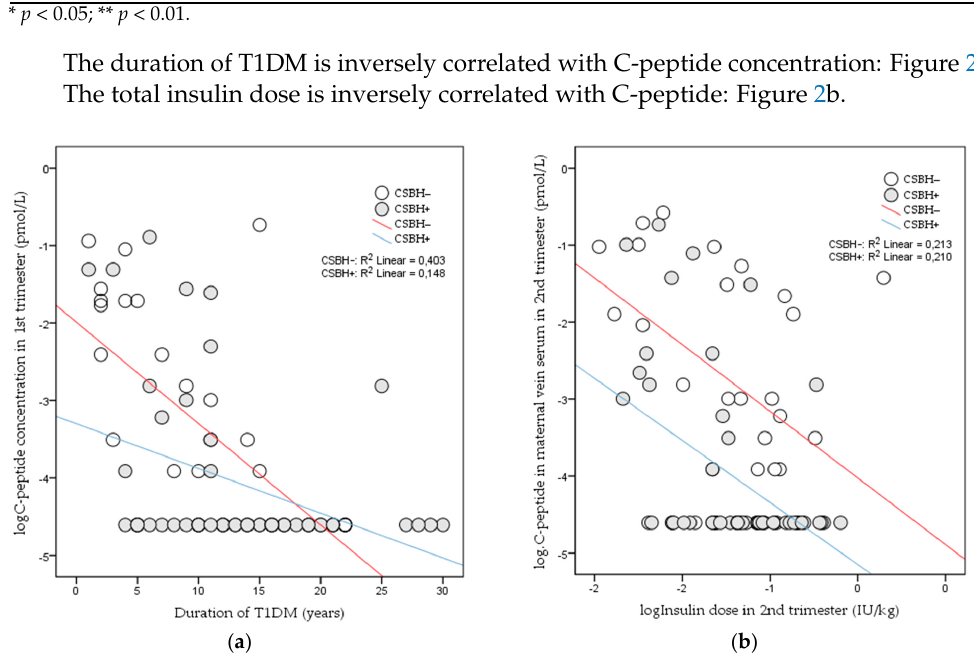
Figure 2. ( a ) Nonparametric linear correlation between duration of T1DM and log C-peptide con- centration (CSBH+, R 2 = − 0.148, p = 0.005; CSBH − , R 2 = − 0.403, p < 0.001). ( b ) Nonparametric linear correlation between total log insulin dose and log C-peptide concentration (CSBH+: R 2 = − 0.210, p < 0.031; CSBH − : R 2 = − 0.213, p < 0.001).